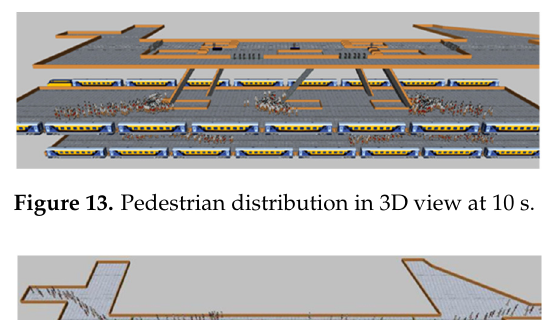
12 of 18 Figure 11. Pedestrian distribution density at 180 s. Figure 12. Pedestrian distribution density at 240 s. The figures show the simulation results of 10 s, 60 s, 180 s, and 240 s. It can be seen from the simulation results that, during the evacuation process, people gathered more